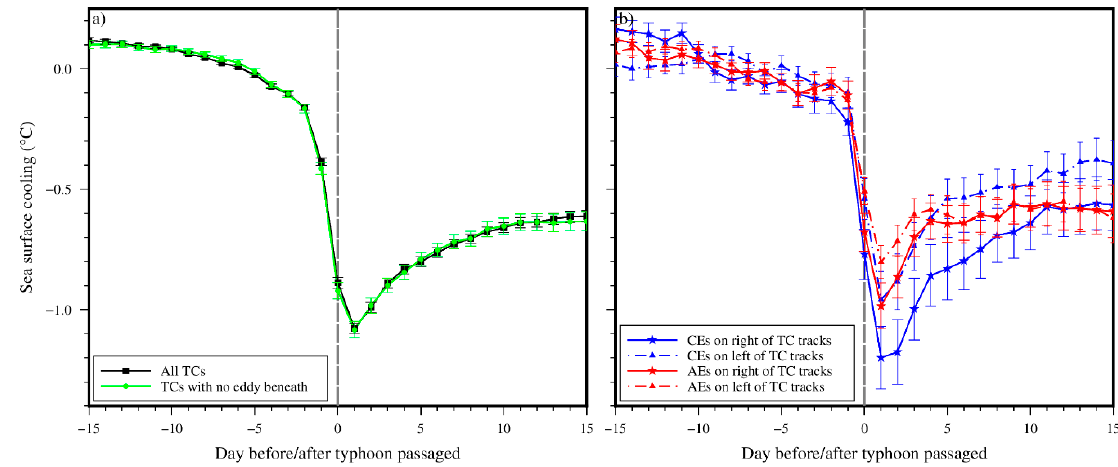
Figure 8. The time series of spatially averaged SST anomalies in typhoon locations or mesoscale eddies during the passage of typhoons. ( a ) The black curve is for all typhoon locations (N = 1273), and the green curve is for typhoon locations with no underlying eddy (N = 515). ( b ) Blue dashed/solid curves describe CEs located to the left/right of typhoon tracks (N = 67/71); red dashed/solid curves describe AEs located to the left/right of typhoon tracks (N = 70/60). Vertical bars represent the standard deviation at each time step.